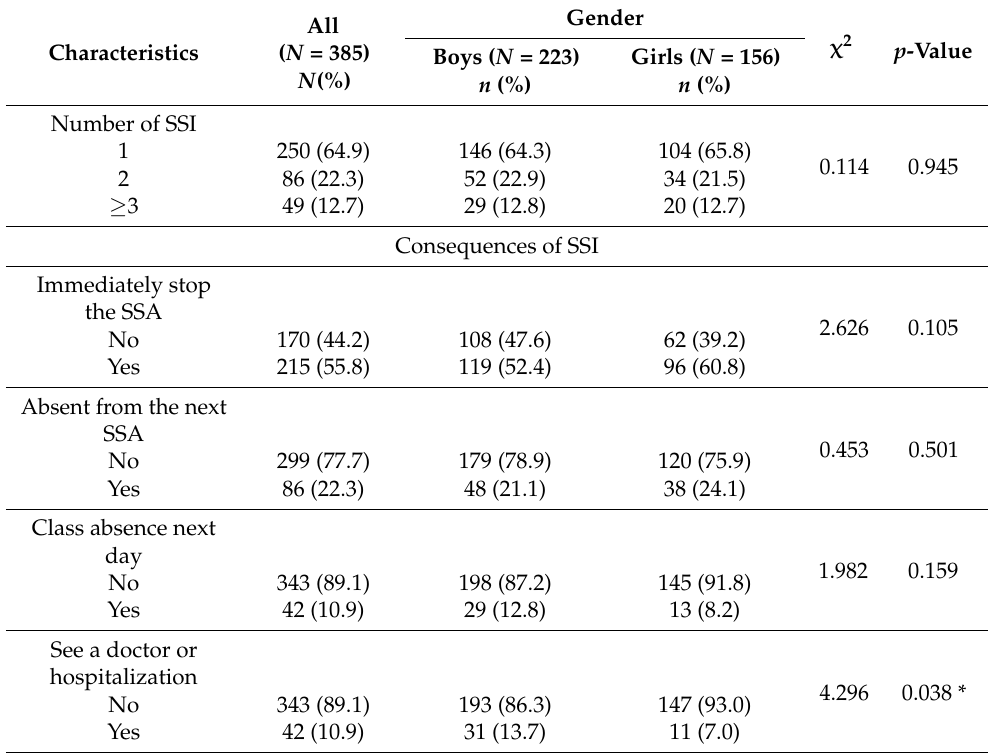
Table 6. Numbers and consequences of school sports injury (SSI) between boys and girls. ( N = 385).